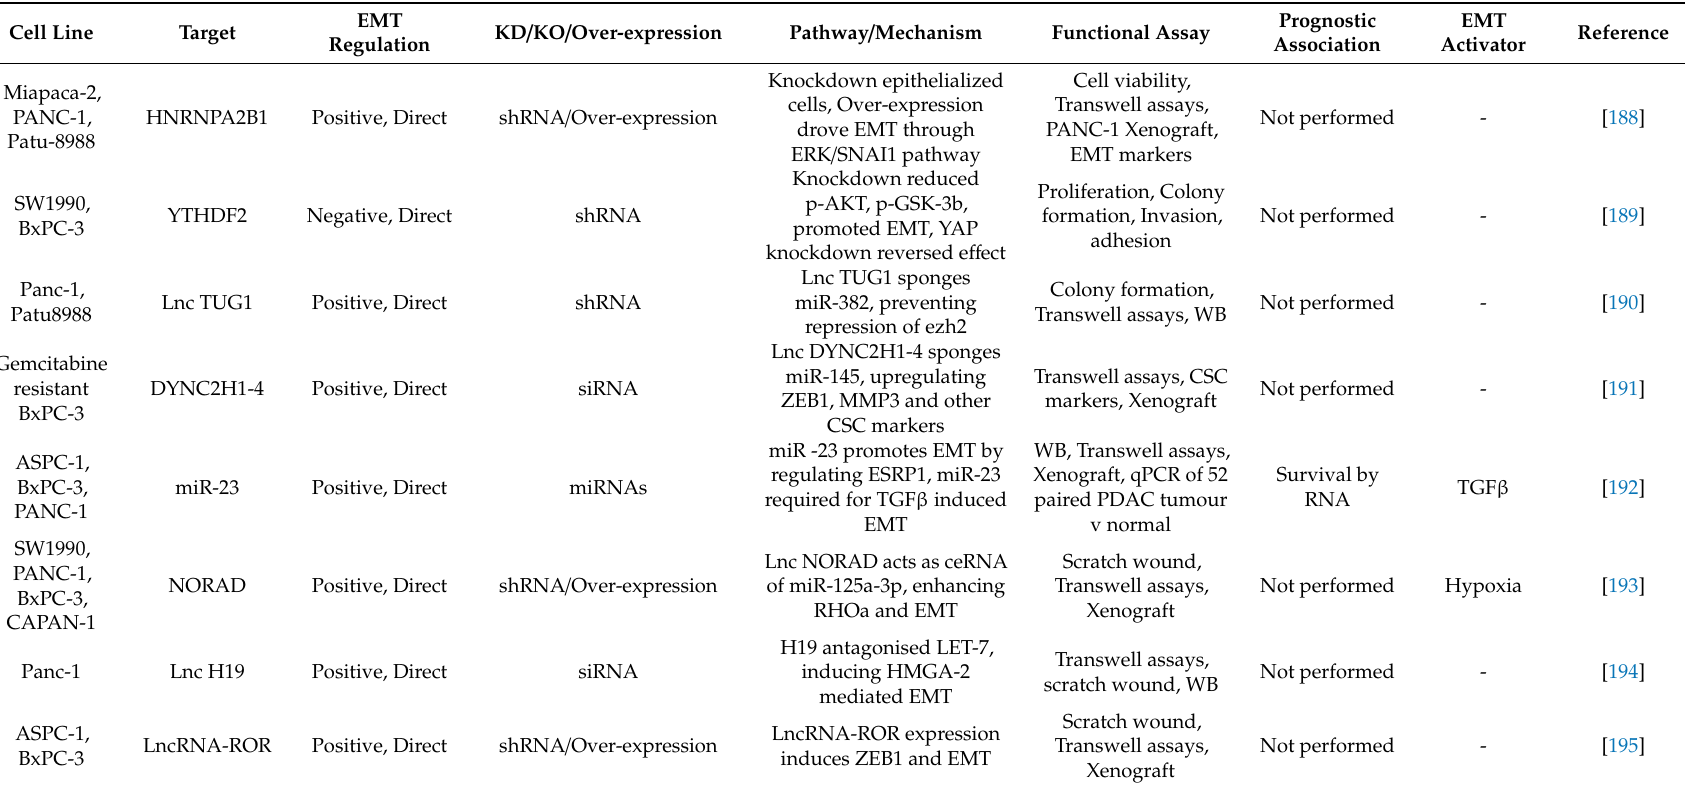
Table 8. Post transcriptional e ff ectors. This table describes factors that may post transcriptionally modulate EMP by controlling stability of mRNA and hence expression of e ff ector proteins. Candidates that exhibit clinical correlation with lymph node metastasis are shown in